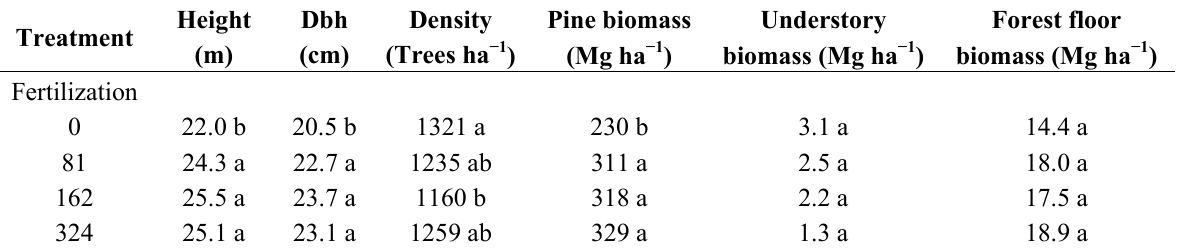
Table 3. Mean height, diameter, stand density and aboveground biomass of 27-year-old loblolly pine stands subjected to four phosphorus fertilization